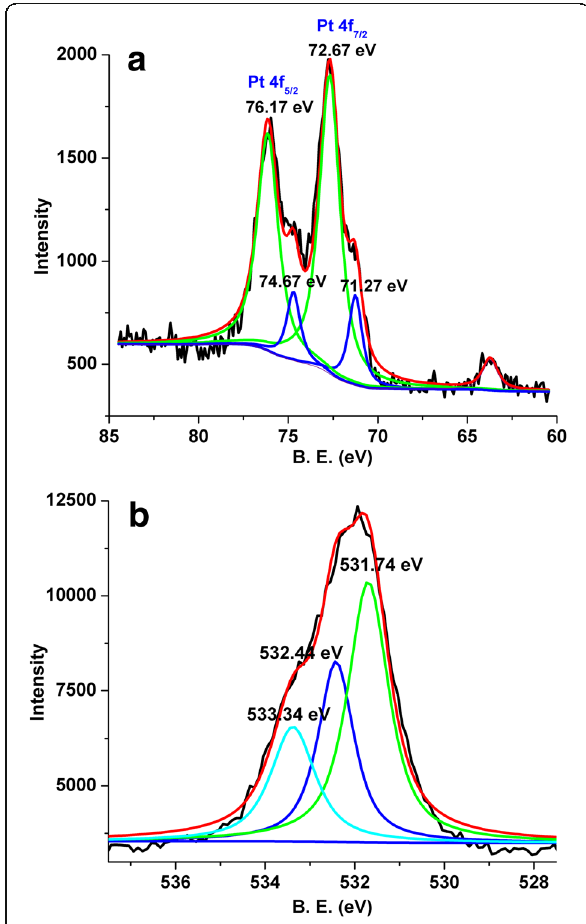
Fig. 6 XPS spectra of a Pt 4f and b O 1s for Pt/La 2 O 3 sample